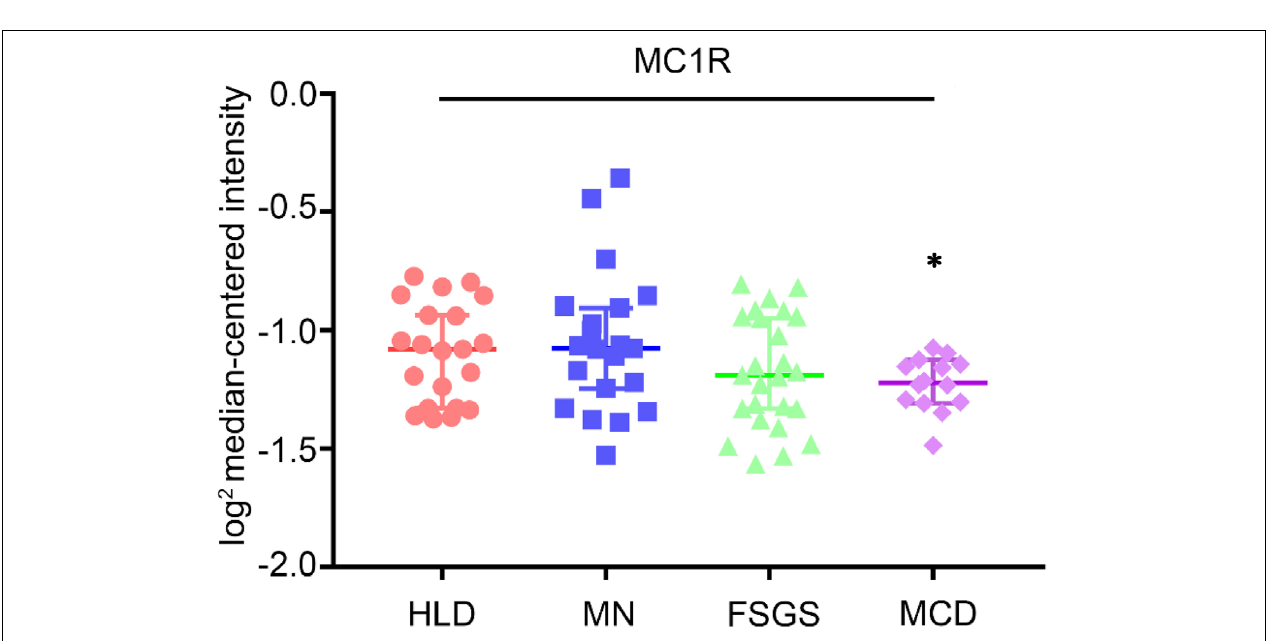
FIGURE 4 | The hypothalamic-pituitary-adrenal axis. Cortisol released by the adrenal cortex in response to ACTH stimulation can negatively regulate the hypothalamus and pituitary, reduce the secretion of both corticotropin releasing hormone (CRH) and arginine vasopressin (AVP), and directly inhibit the pituitary production of ACTH and other melanocortins. The release of ACTH and other melanocortins is also affected by other factors via HPA axis, including stress and circadian rhythms. ACTH, adrenocorticotropic hormone; HPA, hypothalamic– pituitary–adrenal.